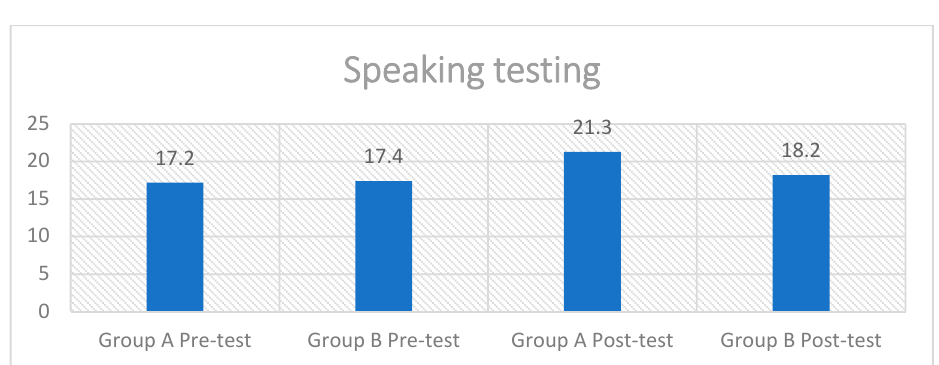
Figure 4. Speaking testing results.